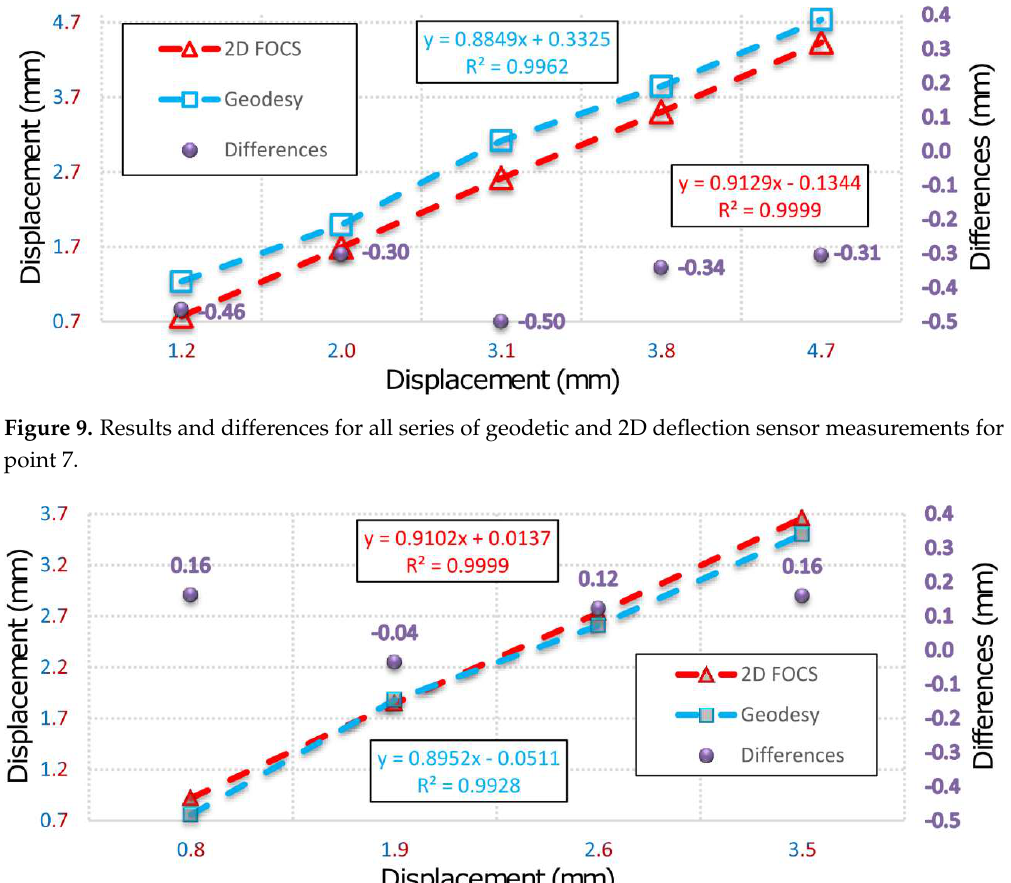
Figure 8. Results of geodetic and 2D deflection sensor measurements without zero series.